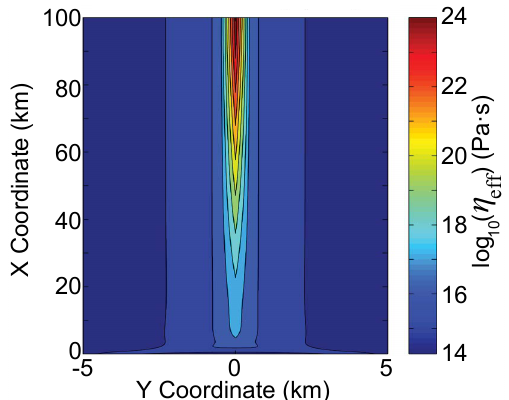
Figure 11. Effective viscosity of semidiurnal models taken at the base of the homogeneous viscosity model. The streaming domain of the ice stream is 10km wide ( − 5 to + 5km). Note that the shear margins have substantially reduced viscosity relative to the central